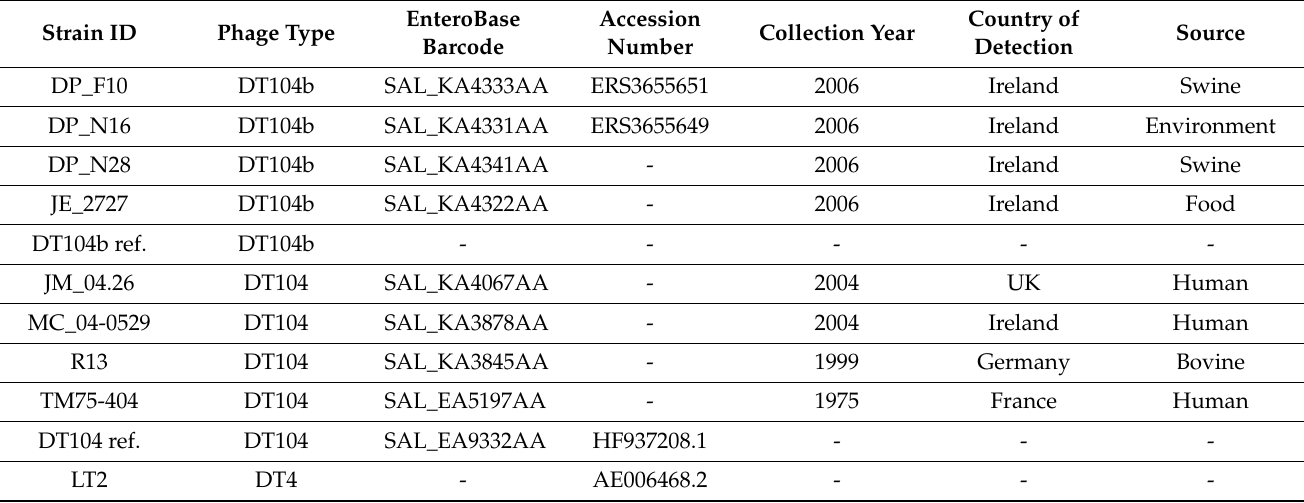
Table 2. List of S. Typhimurium strains used in the